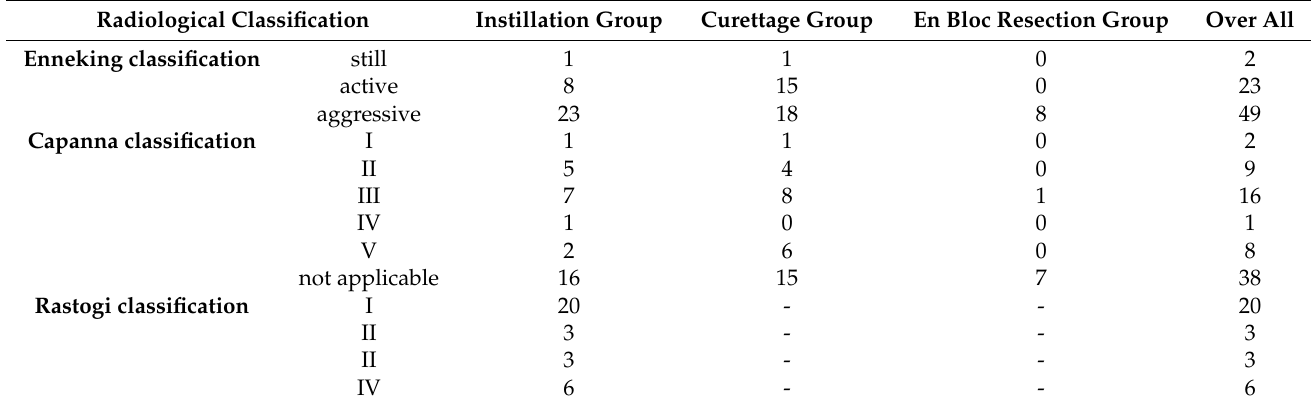
Table 1. Overview of radiological